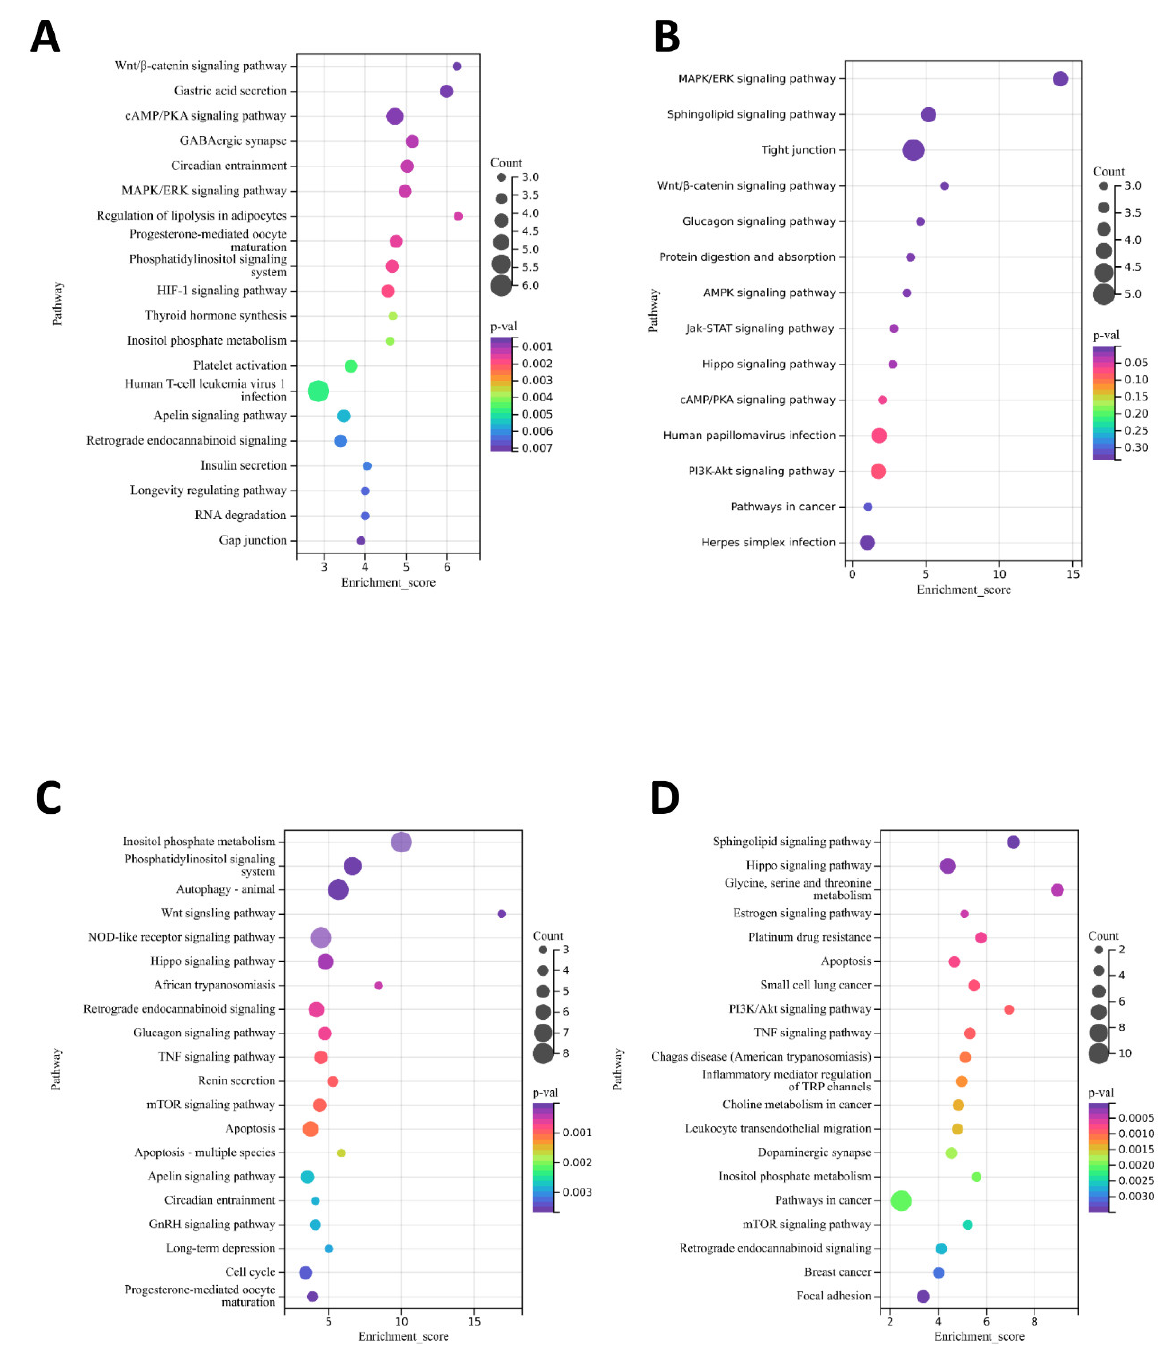
Figure 5. KEGG pathways enrichment analysis was performed for genes with SNP loci in the selected region. ( A ) KEGG pathways enrichment analysis for SW and CF. ( B ) KEGG pathways enrichment analysis for SW and SG. ( C ) KEGG pathways enrichment analysis for SW and QX. ( D ) KEGG pathways enrichment analysis for SW and ZK.